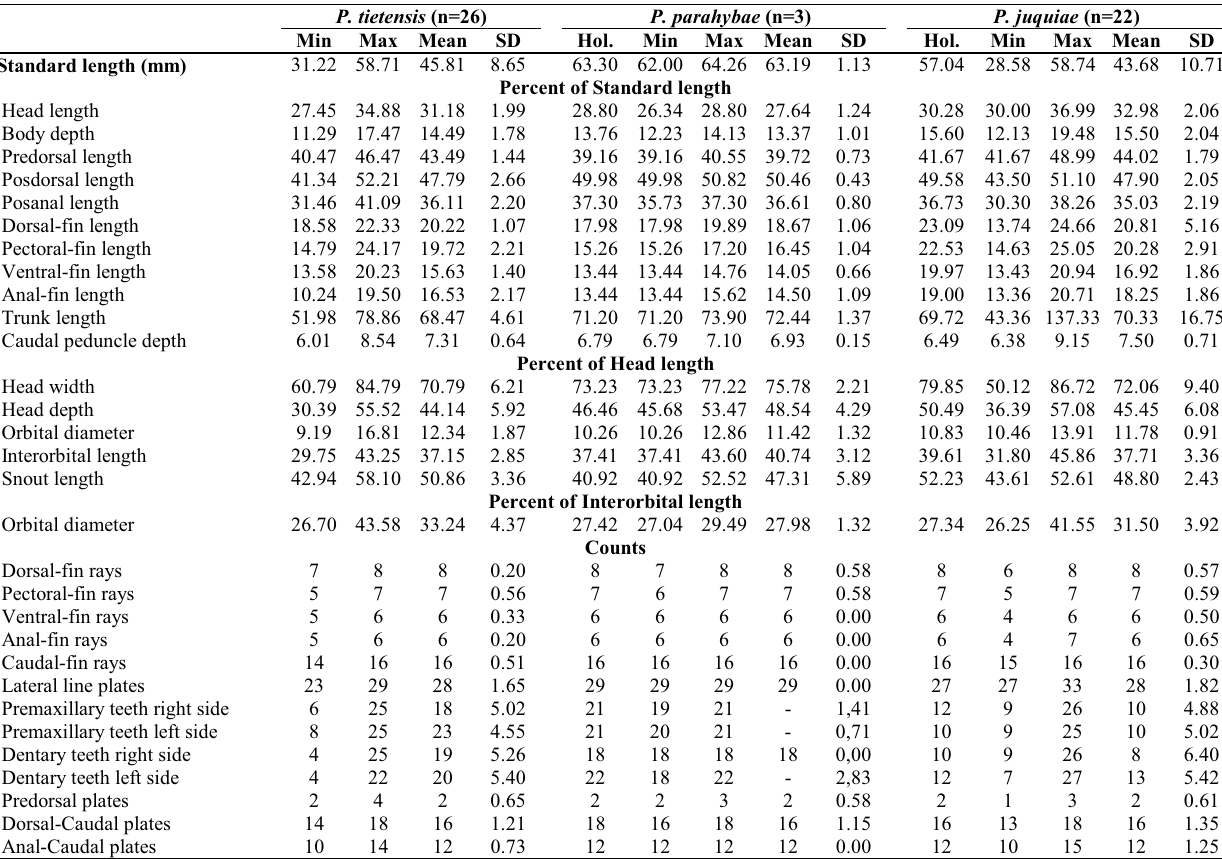
Table 1. Morphometric and meristic data for Pseudotocinclus species. Ratios expressed as percent of standard length, head length or interorbital length. For the meristic values the modal number is presented instead of the mean. Hol –